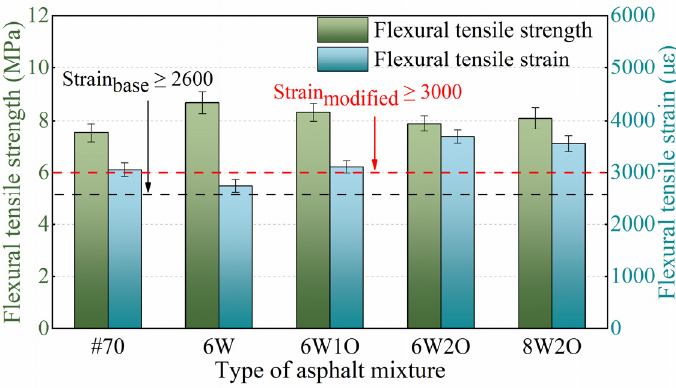
Figure 7. Test results of low-temperature flexural tensile strength and stain.